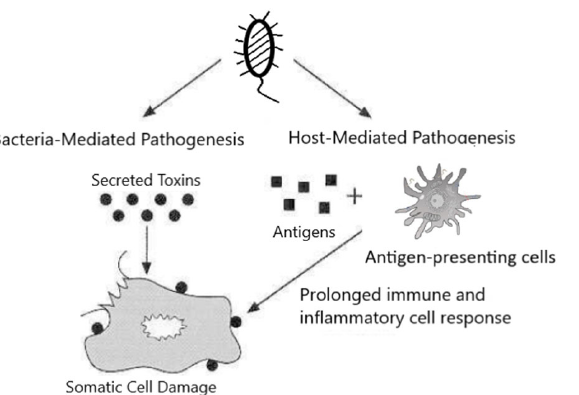
Figure 1. Mechanisms of bacterial pathogenesis: bacteria-induced toxicity and host-mediated damage [2].